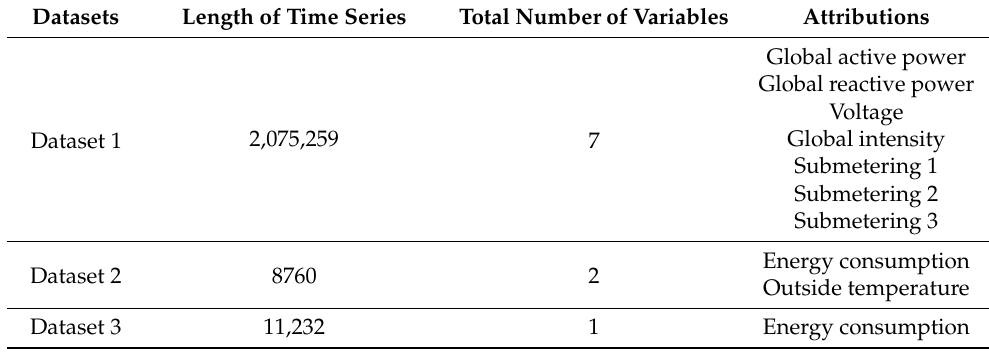
Table 3. Dataset